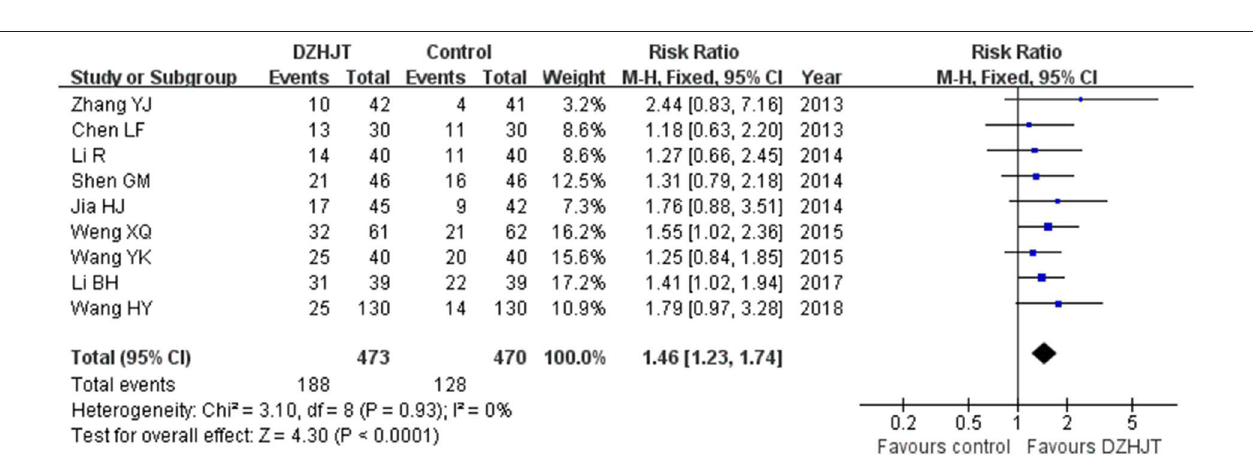
FIGURE 3 | Forest plots showing comparison of marked improvement of abnormal electrocardiogram in patients with or without DZHJT treatment.